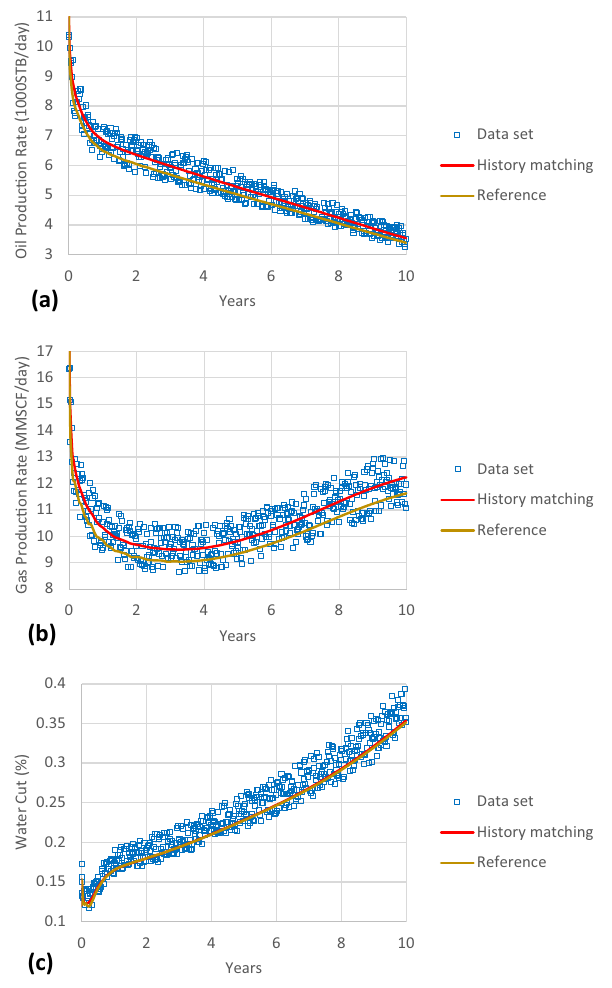
Fig. 4 The history matching results of the oil reservoir for: a oil; b gas, and; c water production rates based on the data set with 5% sys- tematic and 10% random error. The figures also show the reference production rates. The gap between the two lines shows the effect of the errors on history matching